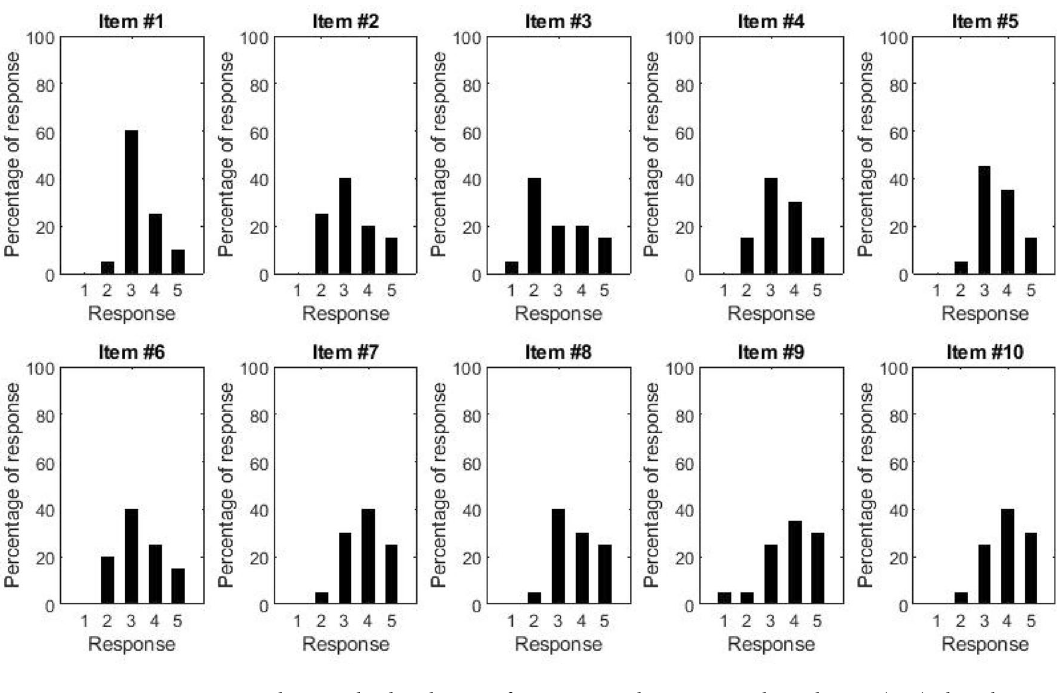
Figure 6. Histograms showing the distribution of responses to the questions about the seat (1–4), the cabin lining (5–6) and the stowage bin (7–10).